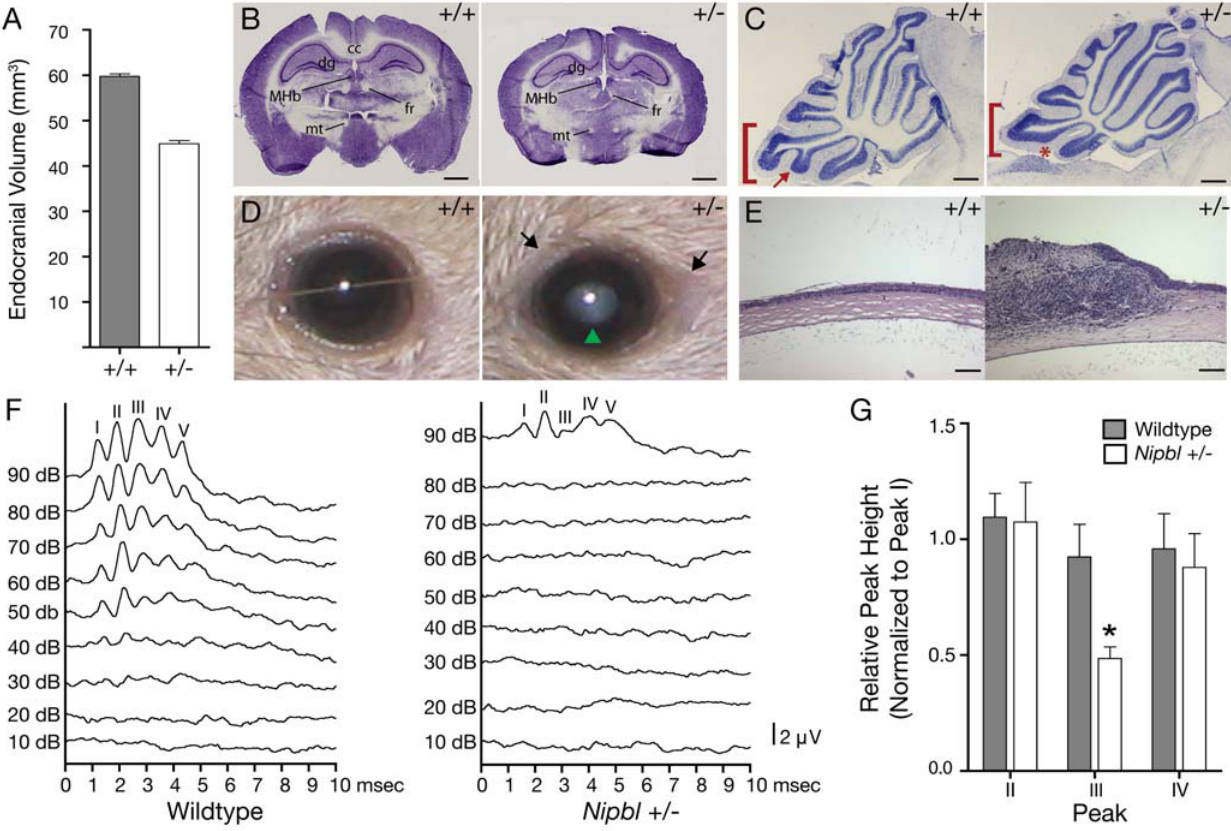
Figure 4. Neuroanatomical, ophthalmic, and auditory phenotypes. (A) Measurements from micro-CT analysis (Figure 3) reveal a 25% reduction in endocranial volume in Nipbl + / 2 mice (data are means 6 SD from 40 wildtype and 23 mutant skulls). (B) Nissl-stained coronal sections of adult wildtype ( + / + ) and Nipbl + / 2 brains illustrate reduced brain size, but grossly normal neuroanatomy. MHb, medial habenular nucleus; fr, fasiculus retroflexus; mt, mammillothalamic tract; dg, dentate gyrus; cc, corpus callosum. Scale bar: 1 mm. (C) Cerebellar hypoplasia in Nipbl + / 2 mice. Cresyl violet-stained midsagittal sections through the cerebellum of adult wildtype and Nipbl + / 2 mice. Mutant cerebella are smaller overall, with a less well- developed folium IX (bracket); note the subfolium (arrow in + / + ) that was missing in 100% of analyzed mutants (asterisk; N=3 Nipbl + / 2 and 3 wildtype littermate controls assessed). Reduction in the size of folium I was also commonly observed in mutants (not shown). Scale bar: 500 m m. (D,E) Corneal pathology in Nipbl + / 2 mice. (D) External view of wildtype and Nipbl + / 2 eyes, demonstrating central opacity (green arrowhead) and swelling/inflammation in the periorbital area (arrows) in the mutant. (E) Sections through wildtype and Nipbl + / 2 eyes, demonstrating disruption of corneal structure in the mutant, including infiltration of cells into the stroma and loss of epithelium. Ocular opacification was observed in 14% (24/ 173) of post-weaning animals tested. Scale bar: 100 m m. (F,G) Hearing deficits in Nipbl + / 2 mice. (F) Auditory brainstem evoked response (ABR) records for a pair of wildtype and Nipbl + / 2 littermates, performed as described [62]. Stacked curves are responses to successive 10 dB increments of a pure-tone stimulus, and display five characteristic peaks of differing latency. In the Nipbl + / 2 curves, hearing loss is indicated by the much higher response threshold (this is seen in less than half of mutants). (G) Average background-subtracted sizes of Peaks II, III, and IV (normalized to Peak I to correct for experimental variation due to differences in electrode placement) for the 90 dB tone response of 6 wildtype and 6 mutant animals. Mutants show marked depression of peak III (P , 0.02, ANOVA), consistent with abnormalities at the level of the auditory nerve or